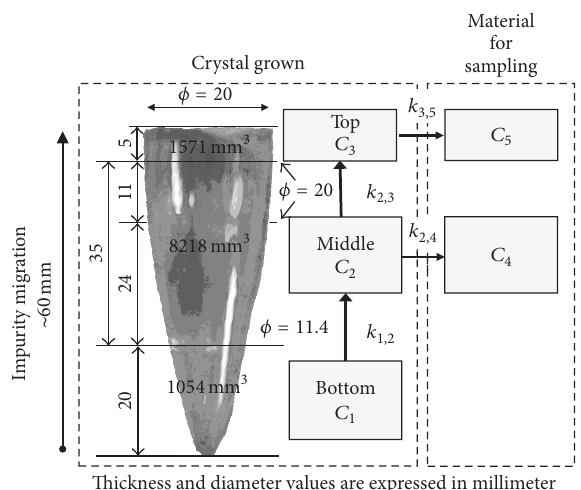
Figure 1: Compartmental model proposed to explain the migration of impurities in the TlBr crystal. The values of the constant 𝑘 𝑖,𝑗 are in Table